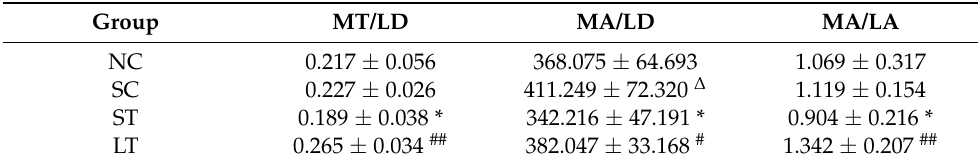
Table 4. Morphological parameters of the iliac artery after training.